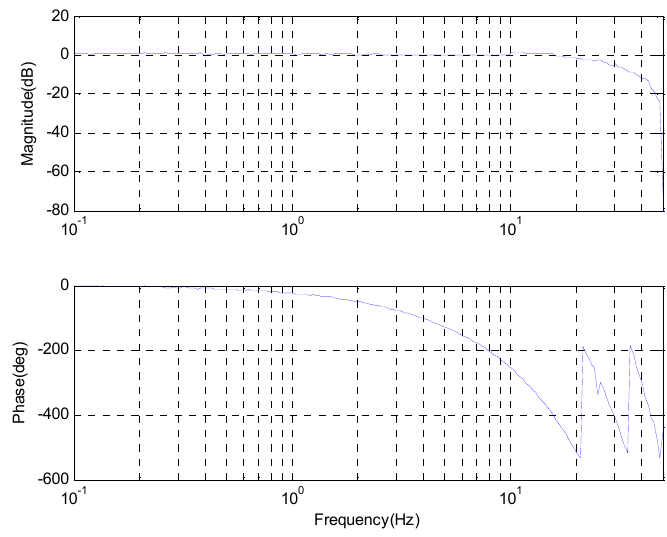
Figure 7. The CCD open-loop Bode response.